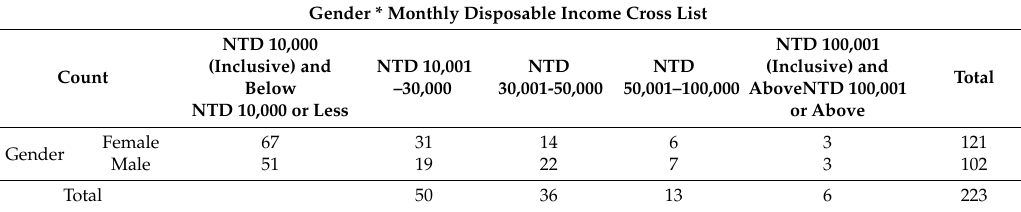
Table 11. Gender and monthly disposable income cross list.